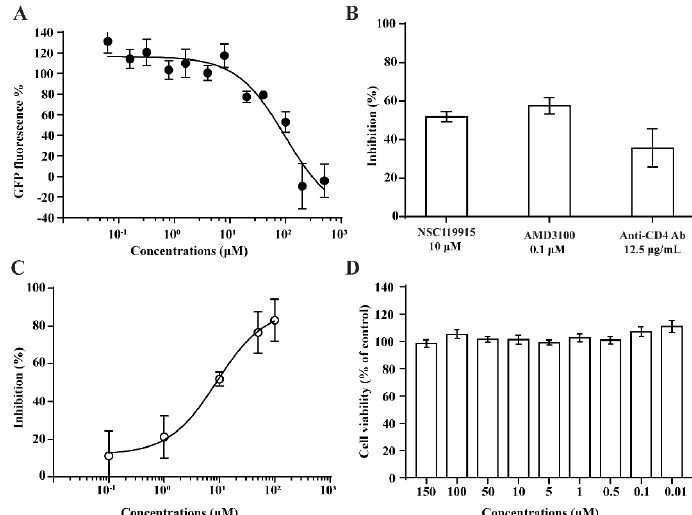
Figure 2. The decreased green fluorescent protein (GFP) fluorescence values indicate that the infection of HIV-1 was inhibited by 3 ( A ). 3 could significantly block HIV-1 entrance into PBMCs as the intercellular p24 level was decreased, AMD3100 and anti-human CD4 antibody used as positive controls ( B ). The HIV-1 entry inhibition assay showed dose-dependent results with an IC 50 value of 9 μM ( C ) without a cytotoxicity effect ( D ).